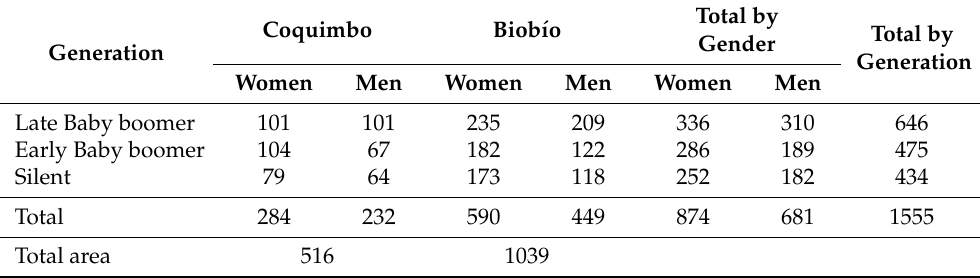
Table 1. The sample